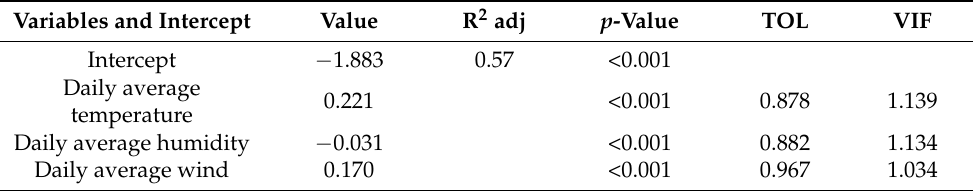
Table 3. Results of stepwise multiple linear regression between meteorological data and rice plant potassium